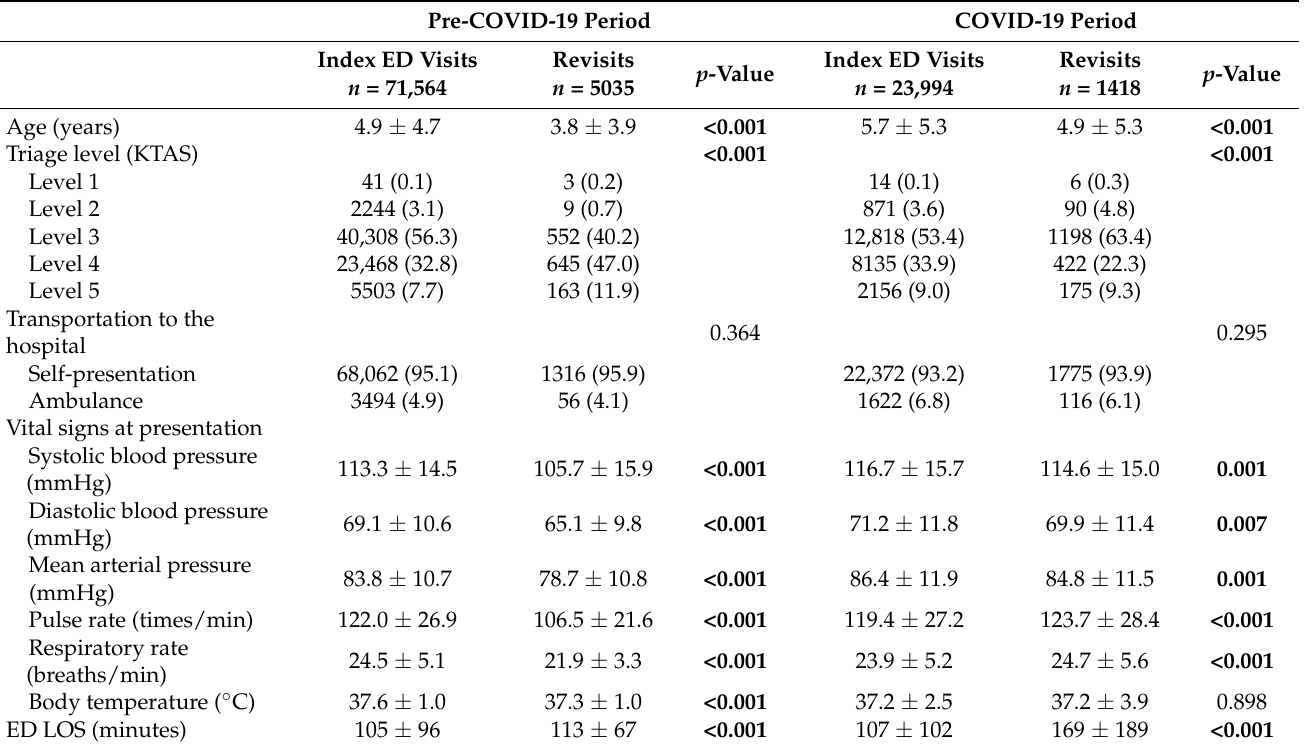
Table 1. Baseline characteristics of patients at index visits and at 7th-day revisits to the emergency